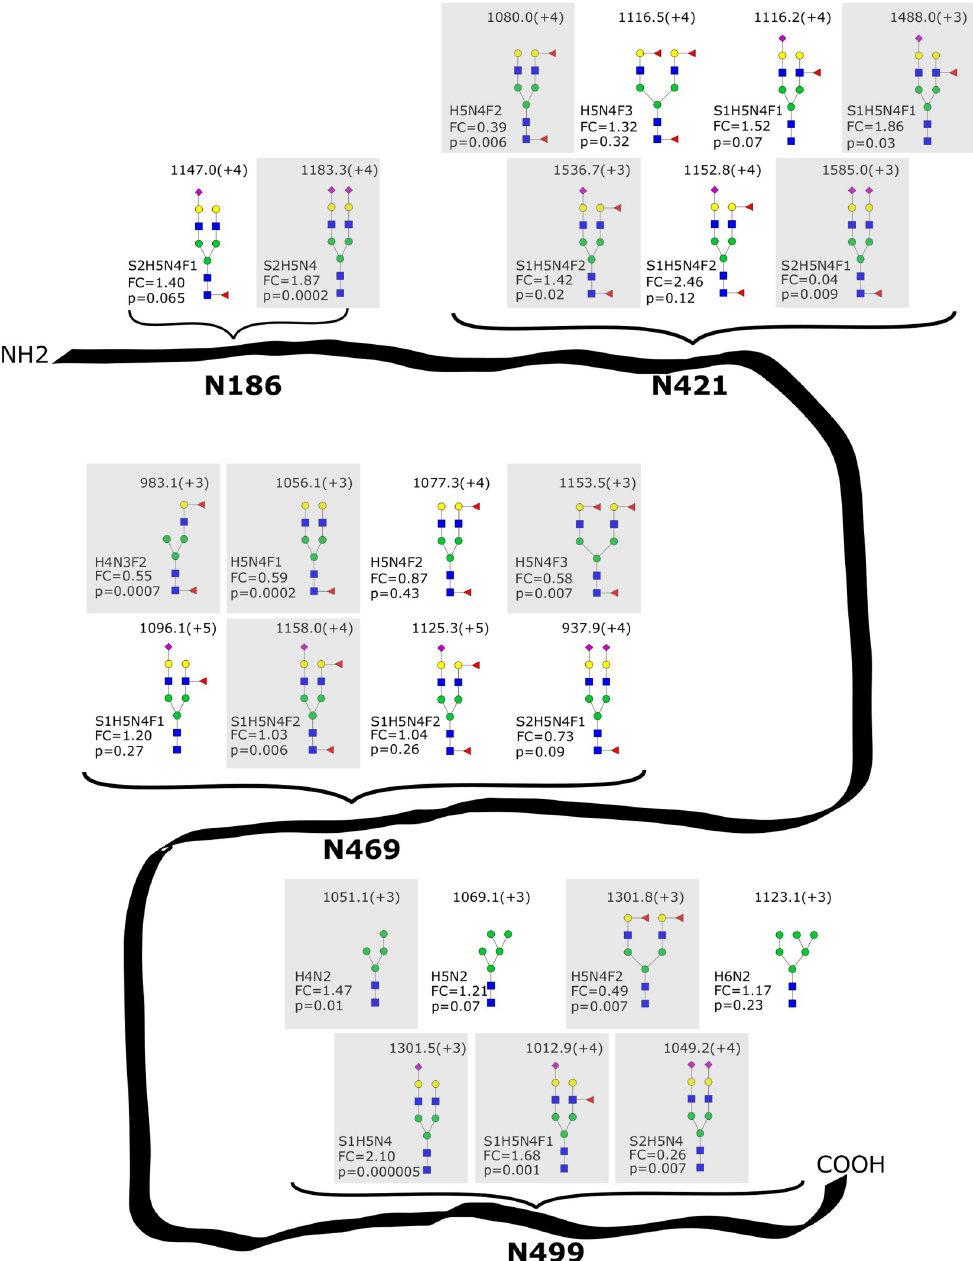
Fig 2. The 24 glycan compositions identified belonging to N-glycopeptides that were part of pIgR. Two glycan compositions were identified at site 186, seven at site 421, eight at site 469, and seven at site 499. The m/z value and charge are given above the glycan structures. Monosaccharide symbols follow the SNFG (Symbol Nomenclature for Glycans) system [18]. For the glycan structures, the following abbreviations were used: H = hexose, N = N-acetylhexosamine, F = fucose, S = sialic acid. Gray boxes indicate a significant (p < 0.05) p-value. The fold change (FC) when abundances were compared between Rochester and OOM mothers is also given, with values greater than 1 indicating a higher abundance of the glycopeptide containing that specific glycan composition in Rochester mothers and values less than 1 indicating a higher abundance in OOM mothers. NH2 indicates the N-terminus and COOH the C-terminus of the